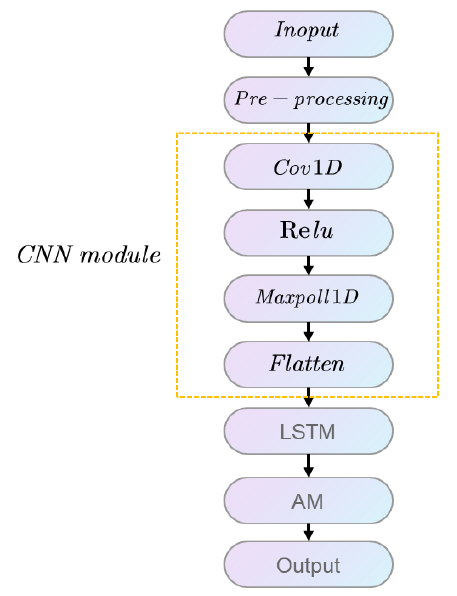
Figure 1. Overall flowchart of CNN-LSTM-AM